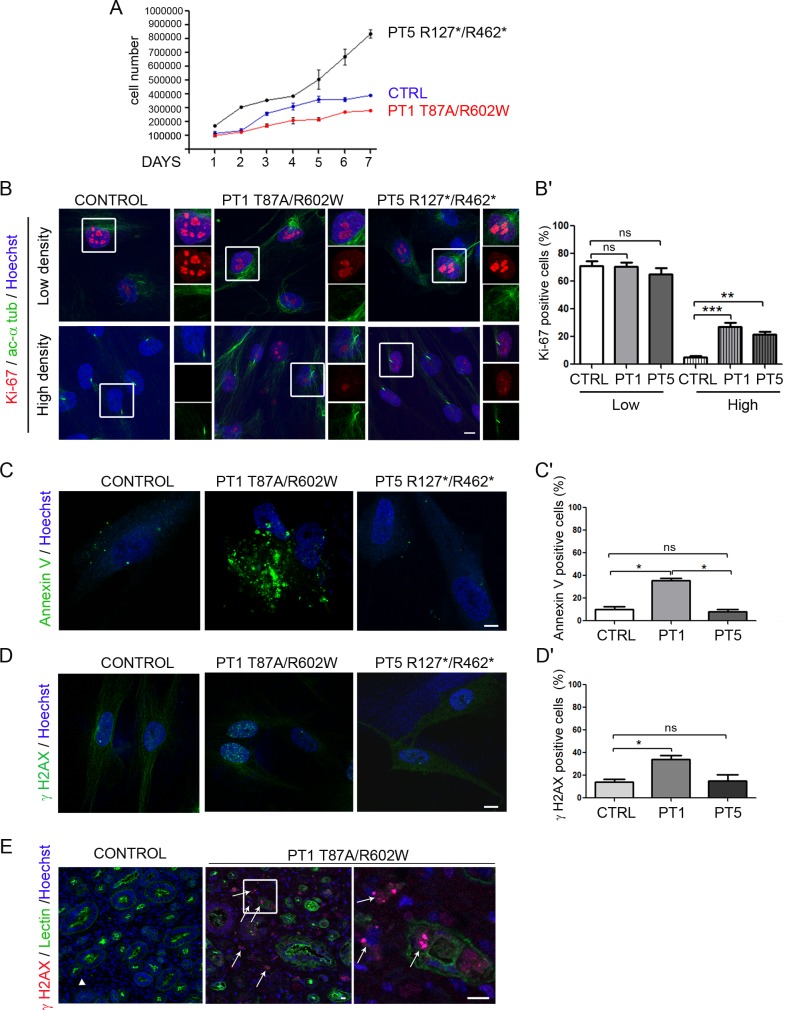
NEK8 missense mutations cause increased apoptosis and DNA damage accumulation in patient fibroblasts.(A) Control (CTRL) and affected individual II.1 from families 1 and 5 (PT1 and PT5) fibroblasts cultured in standard medium were counted for 7 days. Cell population expansions of PT1 and PT5 fibroblasts were significantly slower and faster than control cells, respectively. (B) Immunostaining of Ki-67 (red, marker of proliferating cells) and acetylated α-tubulin (green, cilia) in proliferating (low density) and ciliated (high density) control and patient fibroblasts, showing Ki-67-positive ciliated patient cells. Scale bar, 10 μm. (B’) Percentage of Ki-67-positive cells in control and patient fibroblasts. ***p < 0.001, **p <0.01, calculated via Kruskal-Wallis test. (C) Immunolabelling of Annexin-V showing a higher rate of apoptosis in PT1 fibroblasts compared to control and PT5 cells. Scale bar, 10 μm. (C’) Graph representing the percentage of Annexin-V positive cells in control and patient fibroblasts. (D) Control and patient fibroblasts were grown for 2 days in normal medium (low cell density) and stained for γH2AX (red, marker of double strand breaks) and nuclei (Hoechst, blue). Scale bar, 10 μm. (D’) Quantification of the percentage of γH2AX-positive cells showing an increased staining only in PT1 cells. (E) PT1 kidney biopsy stained for γH2AX (red, marker of double strand breaks), peanut Lectin (green, tubules) and nuclei (Hoechst, blue). Arrows point out γH2AX-positive cells (inset) showing a dramatic increase of the staining. Scale bars, 10 μm. All graphs show the mean ± SEM of at least three independent experiments. *p < 0.05, calculated via Kruskal-Wallis test.